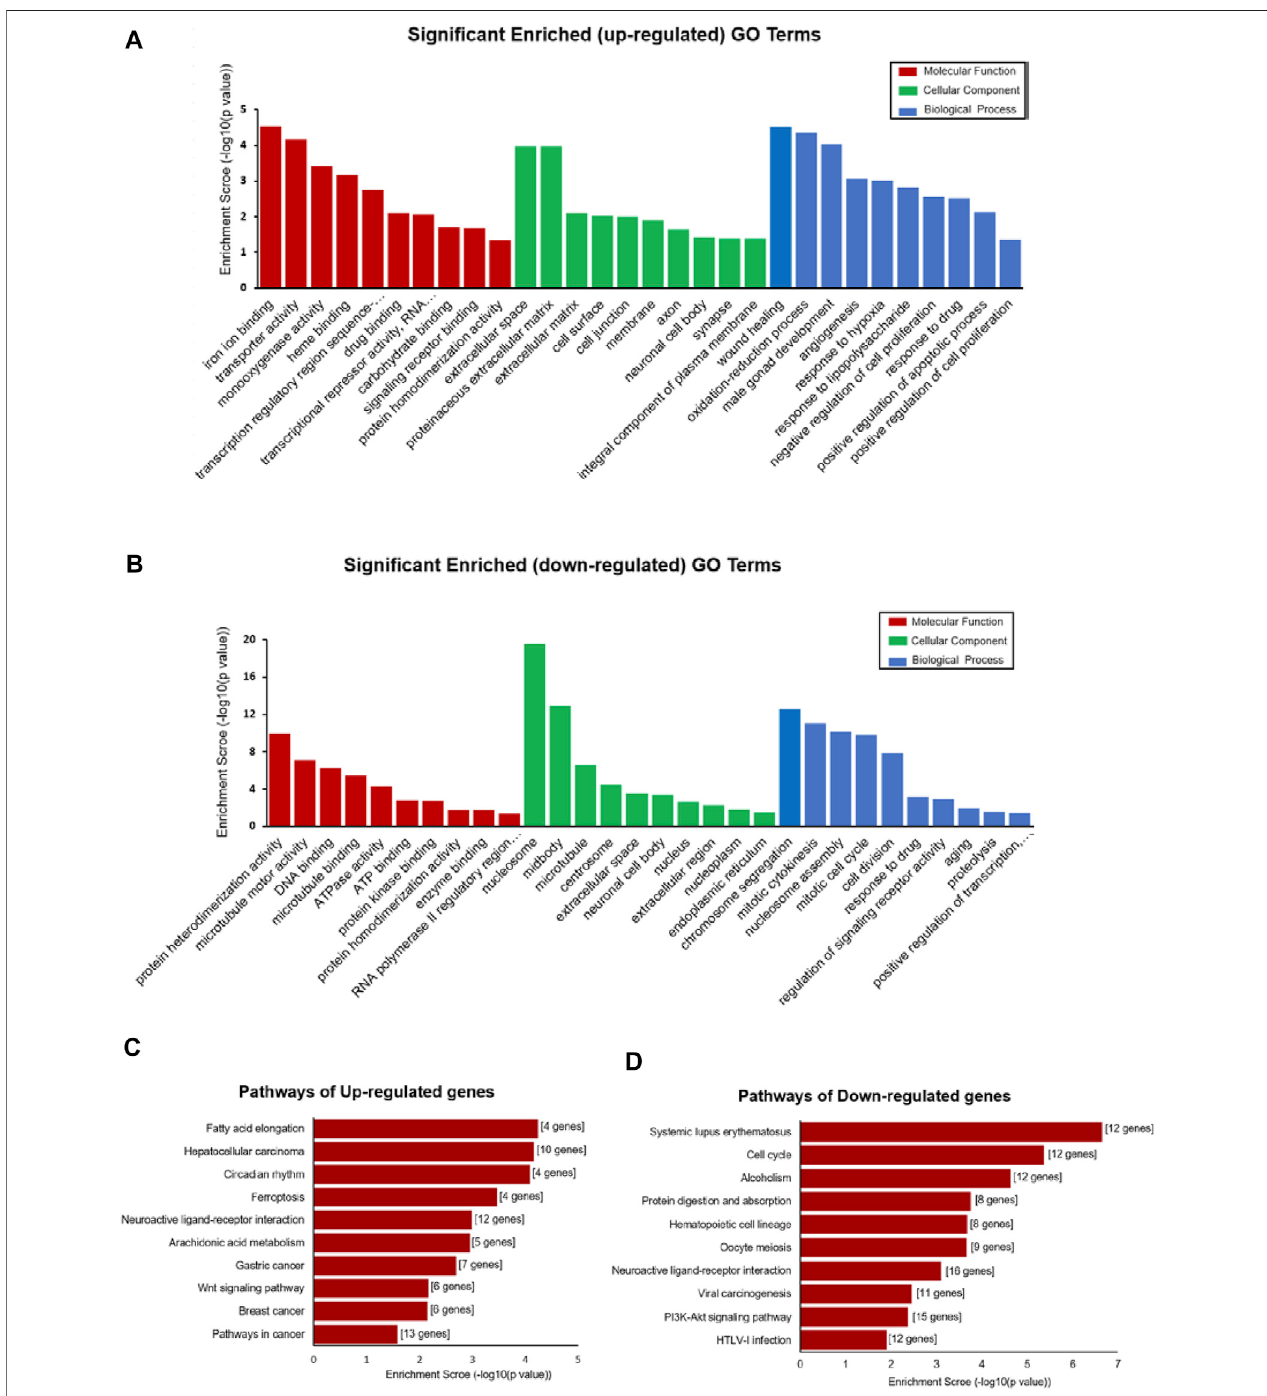
FIGURE 4 | Functional enrichment analysis of DE-mRNAs. (A , B) Top 30 GO terms (comprises cellular component (CC), molecular function (MF), and biological process (BP)) consisting of signi fi cantly enriched upregulated GO terms (A) and downregulated GO terms (B) . (C , D) Pathways depict the signi fi cant difference among the control and DCM groups, signi fi cantly upregulated pathway terms, (C) and downregulated pathway terms (D) .